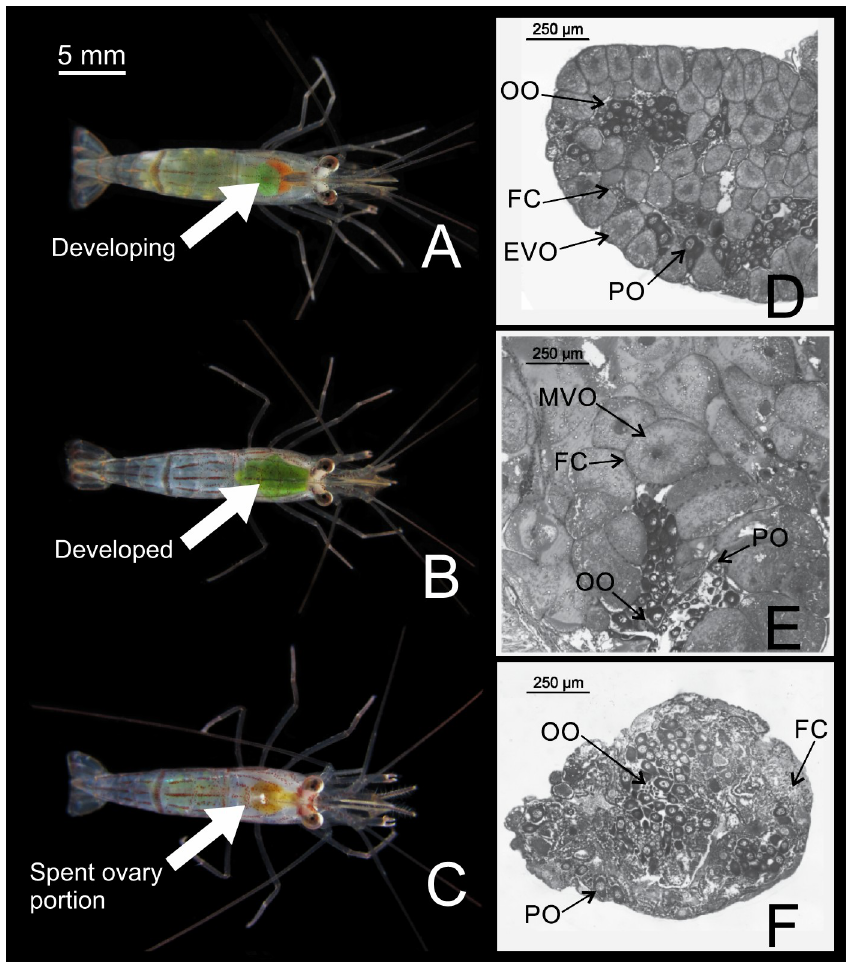
Fig 2. Development of the ovarian portion of the gonad in Lysmata vittata (Stimpson, 1860). (A–C) Stages identified macroscopically. (D) Developing ovary portion. (E) Developed ovary portion. (F) Spent ovary portion. EVO = early vitellogenesis oocyte (early secondary oocyte); FC = follicular cells; MVO = mature vitellogenesis oocyte (advanced secondary oocyte); OO = oogonia; PO = primary oocyte. Tissues were stained with hematoxylin-eosin.